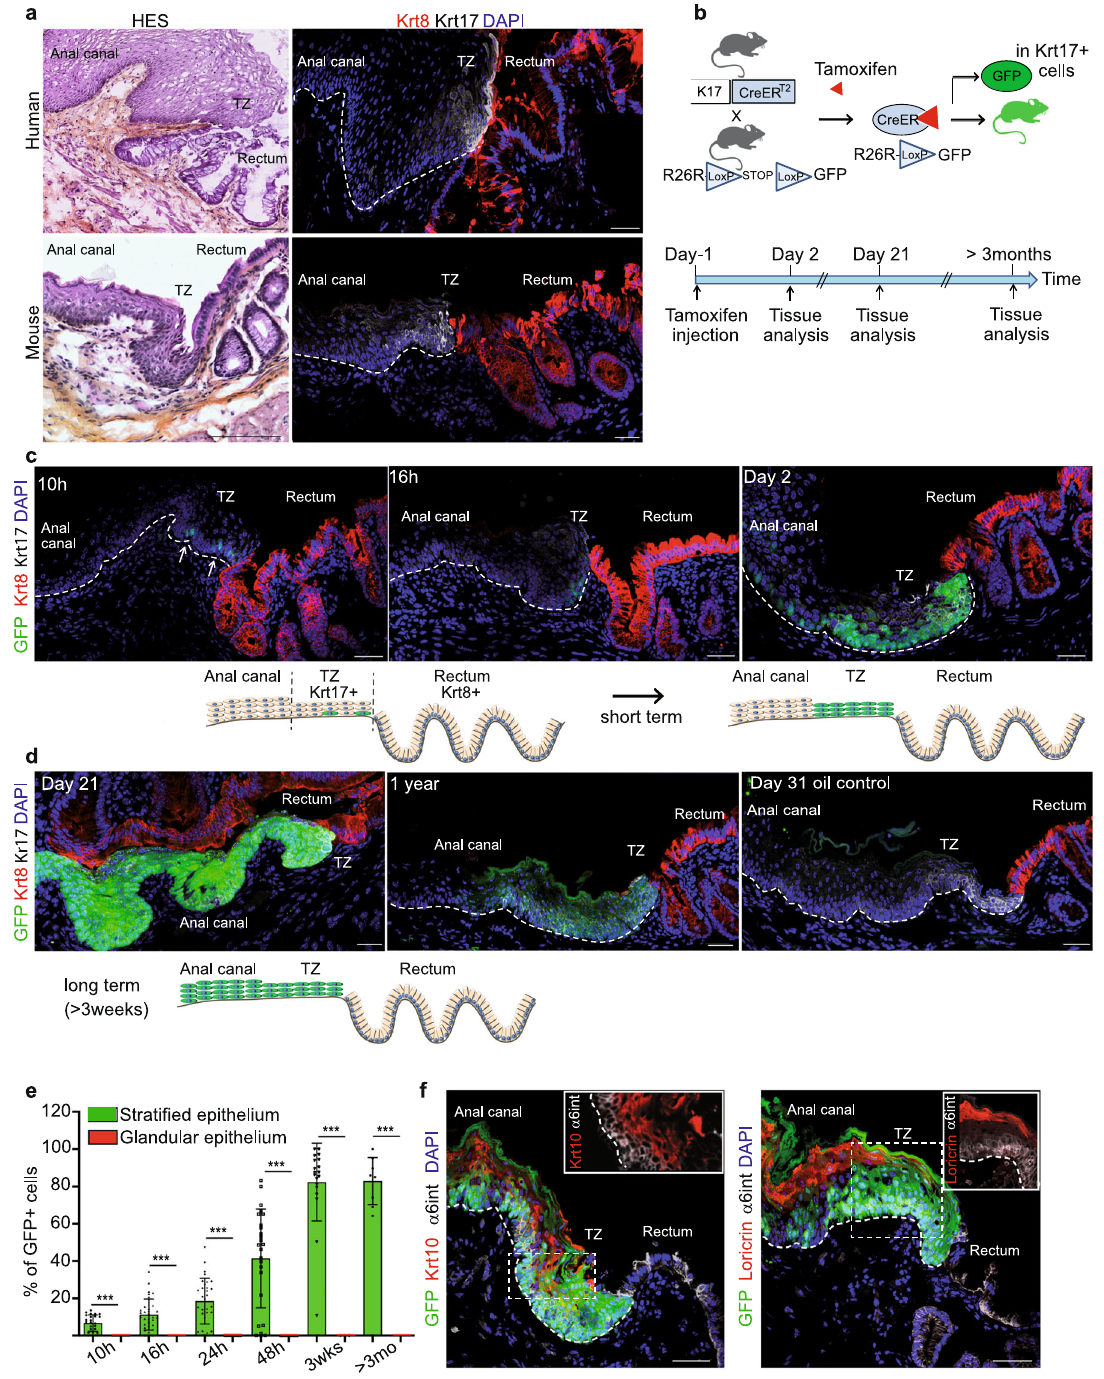
Fig. 1 A population of basal Keratin 17 + cells at the anorectal junction contributes to the anal epithelium during normal homeostasis. a Human and mouse anorectal TZ are histologically (HES) and molecularly similar. A population of keratin 17 (Krt17) expressing cells (white) shown by immuno fl uorescence is present at the anorectal TZ ( n = 55 independent experiments from 58 mice and n = 3 independent experiments from two independent human samples). The rectum expresses keratin 8 (Krt8) (red). Scale bars for HES are 100 and 50 μ m for immuno fl uorescence panels. b Schematic of the mouse model used and time point analyzed after one injection of 2mg of tamoxifen to only label few cells at the TZ. c , d Unipotency of Krt17 + TZ cells (green) during short and long-term lineage tracing. Representative images of n = 3 biologically independent samples at each time point are shown. Dashed lines delineate the epithelium from the stroma. Scale bars are 50 μ m. e Quanti fi cation of the % of GFP cells in strati fi ed and glandular tissue ( n = 3 mice per time point) (Source data are provided as a source data fi le). Two-tailed paired t -test; error bars, mean ±SD *** p <0.0001. f Krt17 + TZ cells give rise to differentiated suprabasal layer cells of the anal canal (4 weeks post-tamoxifen injection) positive for Krt10 (red) and to corni fi ed layer cells positive for Loricrin (red). α 6 integrin (in white) marks the basal layer. Scale bars are 50 μ m; Insets for Krt10 and Loricrin are zoom in 1.5-fold and 1.1-fold, respectively.